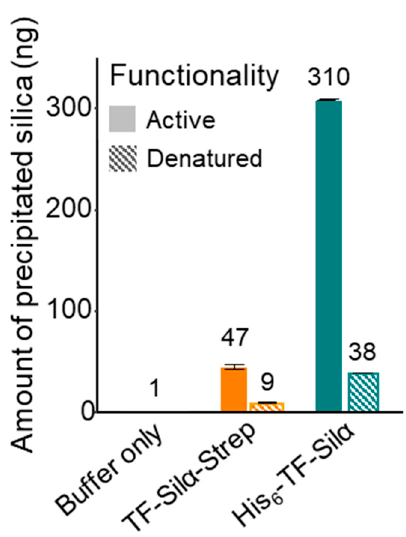
Figure 7. Graph showing amount of silica produced after 1 h, from the hydrolysis of TEOS by fresh (solid bars) and heat denatured (hatched bars) His 6 -TF-Sil α and TF-Sil α -Strep. Error bars are calculated based on the standard deviation of triplicate experiments.